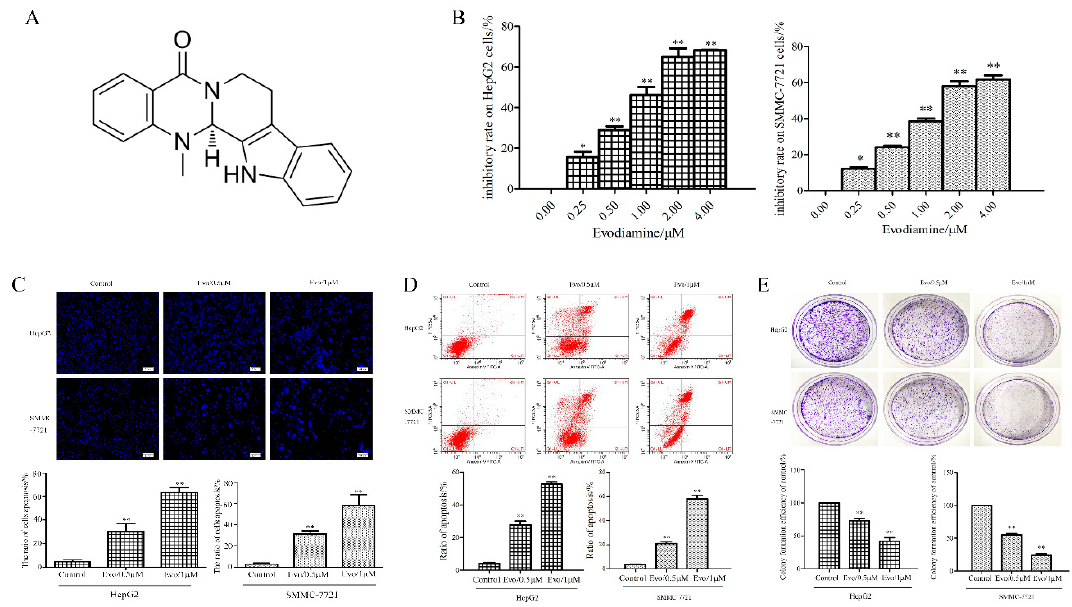
Figure 1. Evodiamine (Evo) inhibits cell viability and induces cell apoptosis in hepatocellular cancer (HCC) cells in vitro. ( A ) Chemical structure of Evo. ( B ) HepG2 and SMMC-7721 cells were incubated with increasing concentrations of Evo (0, 0.25, 0.5, 1, 2, and 4 µM) for 24 h. Cell Counting Kit-8 (CCK-8) assay was performed to detect the cytotoxic effect of Evo. ( C ) Hoechst 33258 staining of HepG2 and SMMC-7721 cells after being treated with Evo (0, 0.5, and 1 µM) for 24 h. Apoptotic cells were identified by the presence of bright-blue fluorescent and highly condensed or fragmented nuclei (×40). ( D ) Flow cytometry histograms of cell apoptosis distribution after treatment with Evo (0, 0.5, and 1 µM) for 24 h by Annexin V-FITC/PI double staining. ( E ) Representative images from the colony-formation assay. HepG2 and SMMC-7721 cells were incubated with or without Evo (0, 0.5, and 1 µM) for 24 h and allowed to grow into colonies for another 16 days. Values are means and standard errors of three separate experiments (* p < 0.05 and ** p < 0.01 versus control).